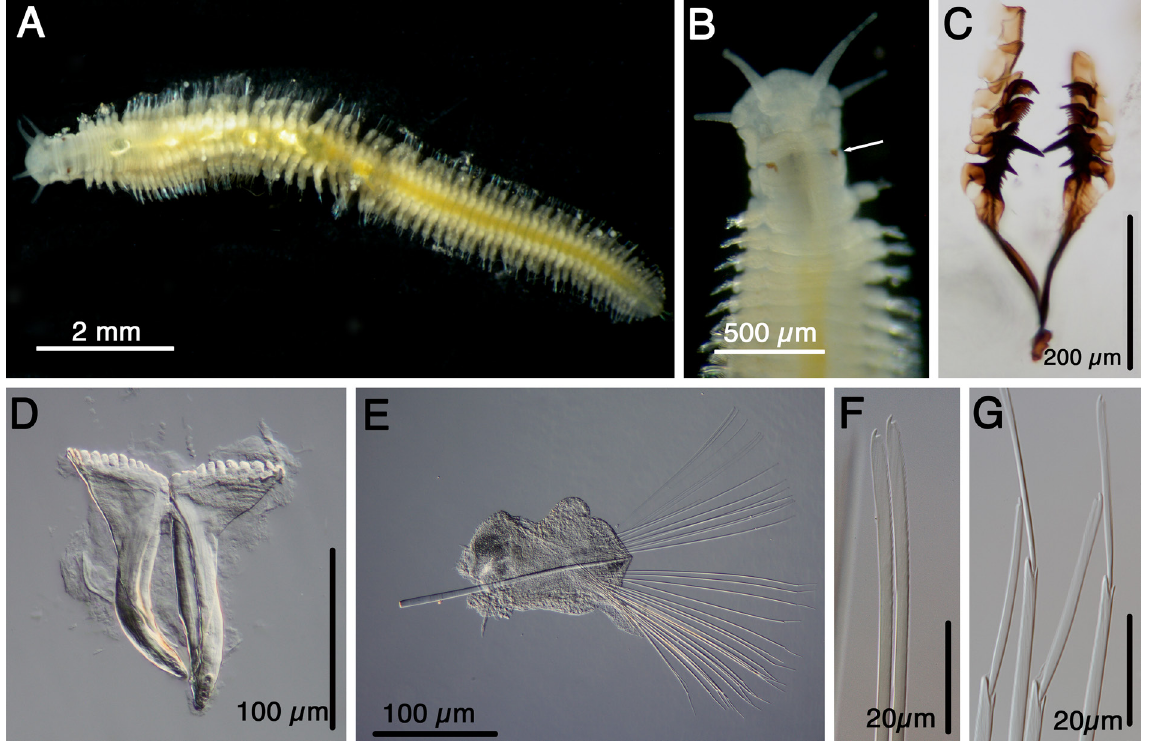
Fig. 9. Ophryotrocha bohnorum sp. nov. A . Whole body of living paratype (SIO-BIC A14095). B . Dorsal view of anterior living holotype (SIO-BIC A14092) one of the distinctive brown spots on the peristomium indicated by white arrow. C . Mandibles of paratype (SIO-BIC A14093). D . Maxillae of paratype (SIO-BIC A14093). E . Parapodium of paratype (SIO-BIC A14093). F . Simple supra-acicular chaetae of paratype (SIO-BIC A14093). G . Compound sub-acicular chaetae of paratype (SIO-BIC